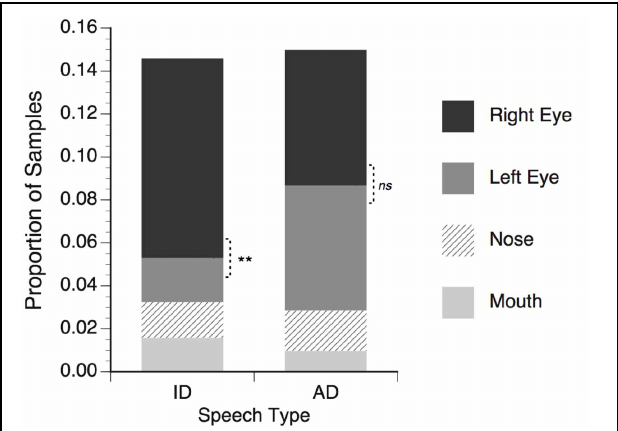
head orientation, shown in red. (B) Shows a frame from one of the video stimuli, with the dynamic regions of interest for the right eye, left eye,